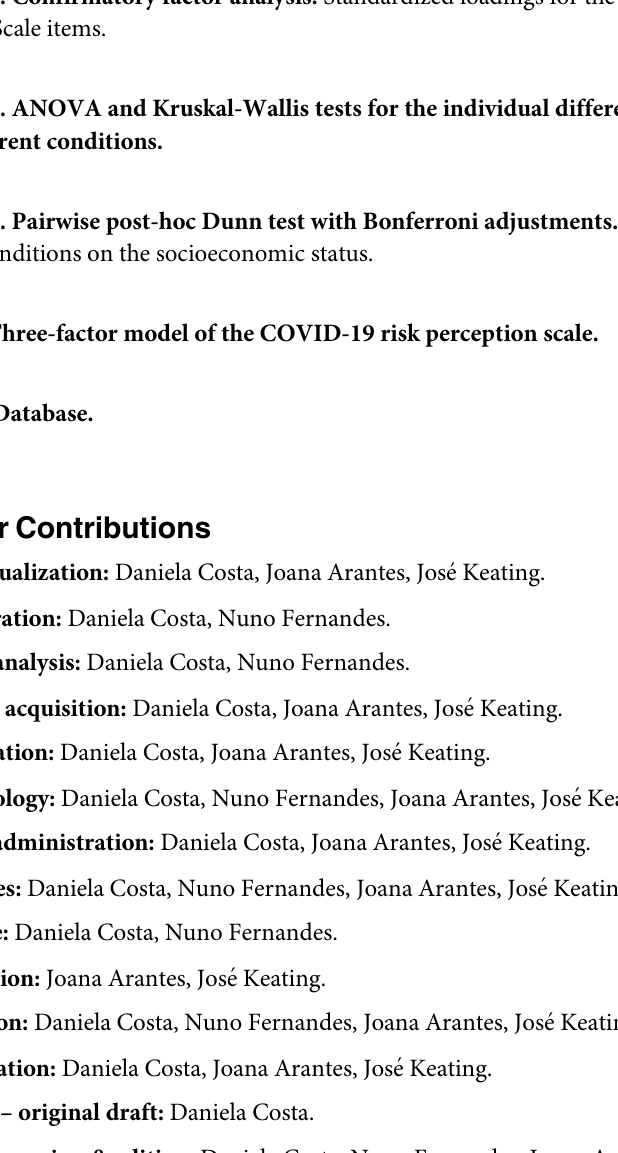
S1 Table. Description of the sociodemographic and COVID-19 variables. Results are shown in absolute and relative (%) frequencies. S2 Table. Confirmatory factor analysis. Standardized loadings for the COVID-19 Risk Per- ception Scale items. S3 Table. ANOVA and Kruskal-Wallis tests for the individual difference’s variables across the different conditions. S4 Table. Pairwise post-hoc Dunn test with Bonferroni adjustments. Results from the dif- ferent conditions on the socioeconomic status. S1 Fig. Three-factor model of the COVID-19 risk perception